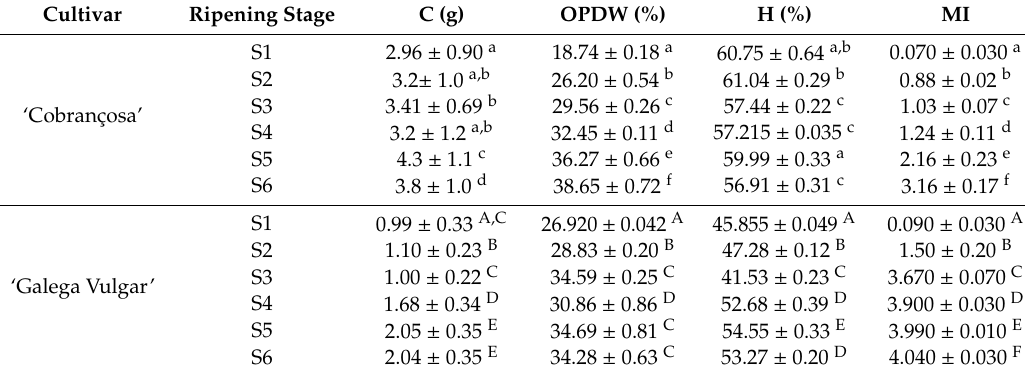
Table 2. Evaluation of olive fruit caliber (C), fat content in dry matter (OPDW), moisture (H) and maturity index (MI) along ripening, for ‘Cobrançosa’ and ‘Galega Vulgar’ (mean ± standard